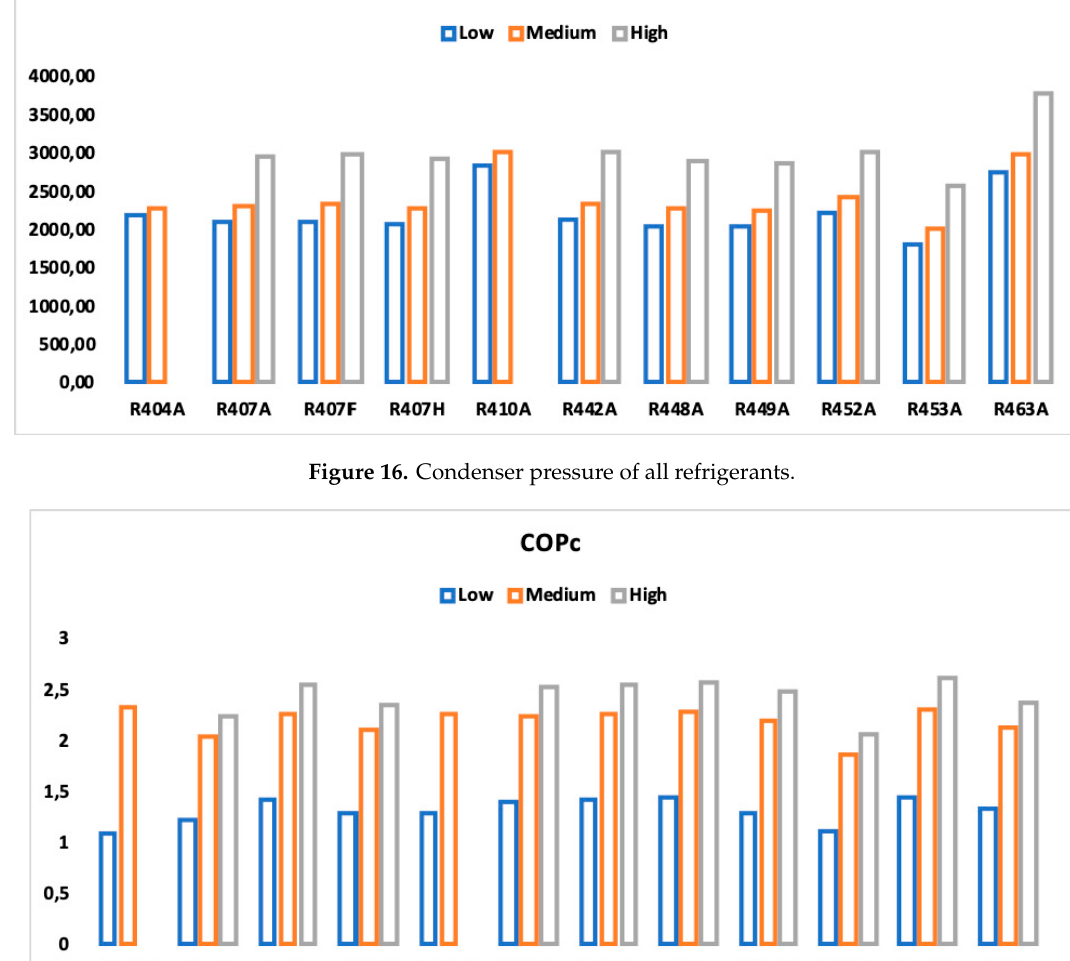
Figure 16. Condenser pressure of all refrigerants.